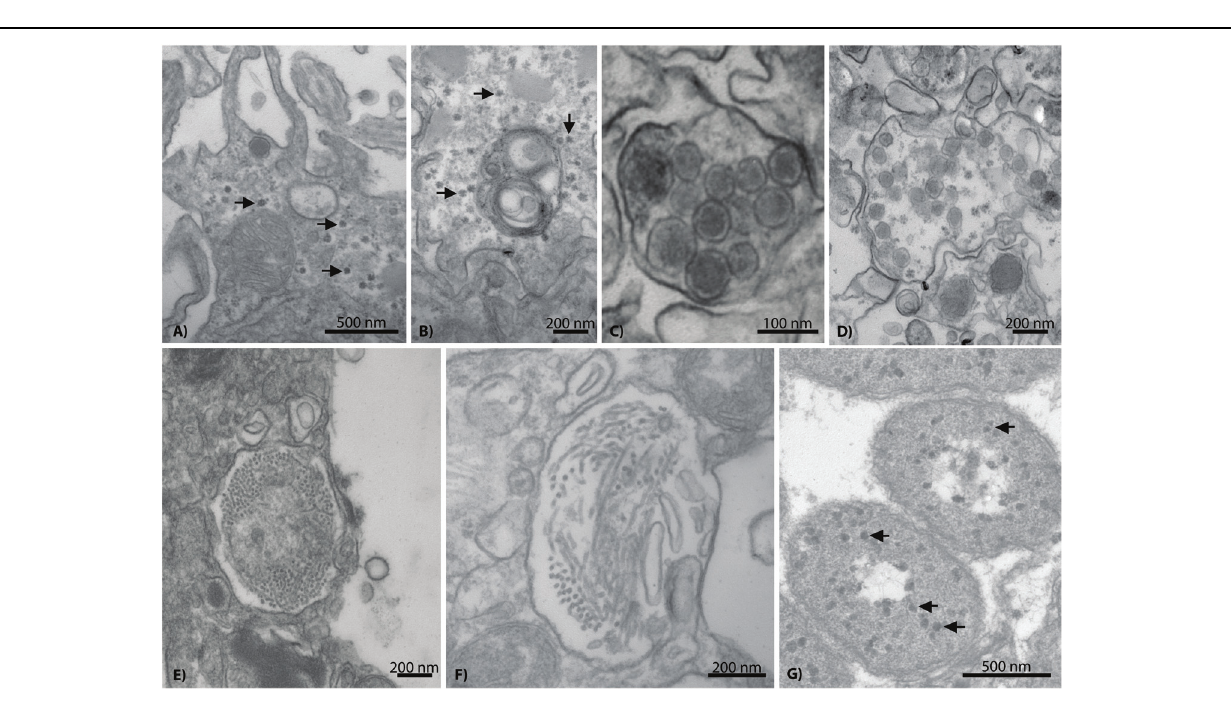
FIGURE 7 | Representative examples of additional VLP diversity observed in Acropora aspera and Acropora millepora . In (A,B) , arrows indicate star-shaped VLPs that are morphologically reminiscent of circovirus and nanovirus particles. (C,D) Depict retrovirus-like VLPs; the VLPs in (C) are within a cell vacuole. (E,F) Appear to be long filamentous VLPs within large ovoid viral factories. In (G) , arrows indicate phage-like VLPs within bacterial cells (large, ovoid polygons) enclosed in peri-algal spaces of the host gastroderm. Scale bars are 200 nm, unless otherwise